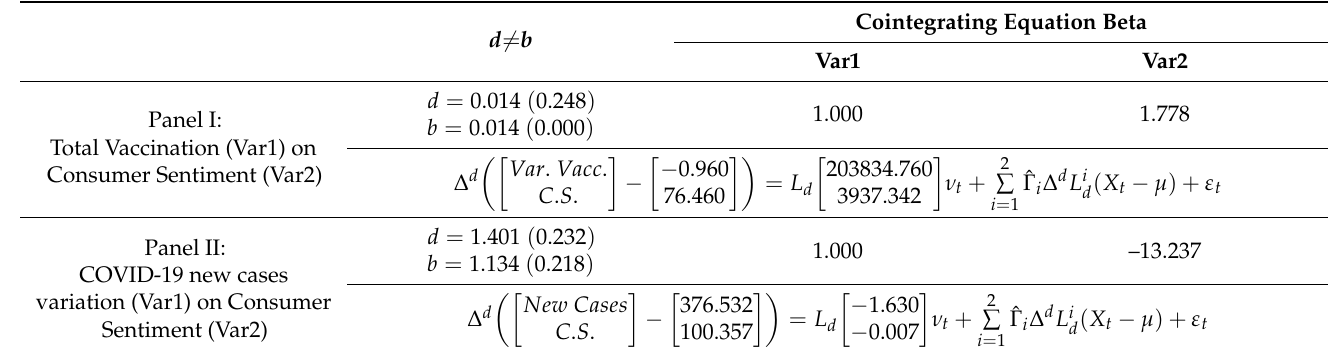
Table 4. Results of the FCVAR